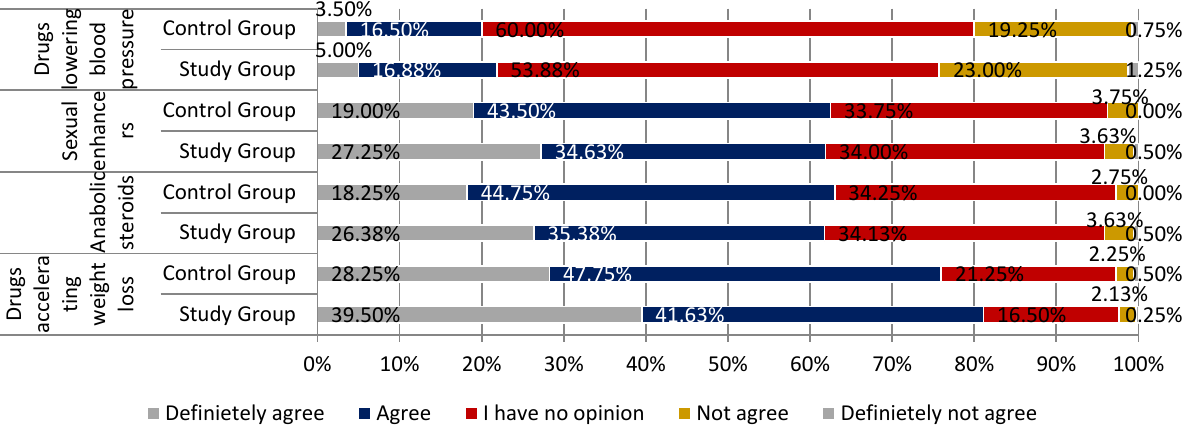
Figure 9. The most frequently falsified medicines in the opinion of respondents summary (part 2).